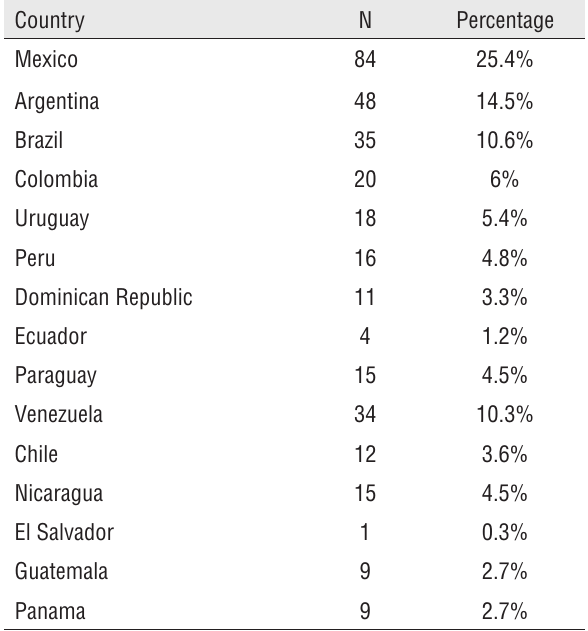
Table 1 - participants by